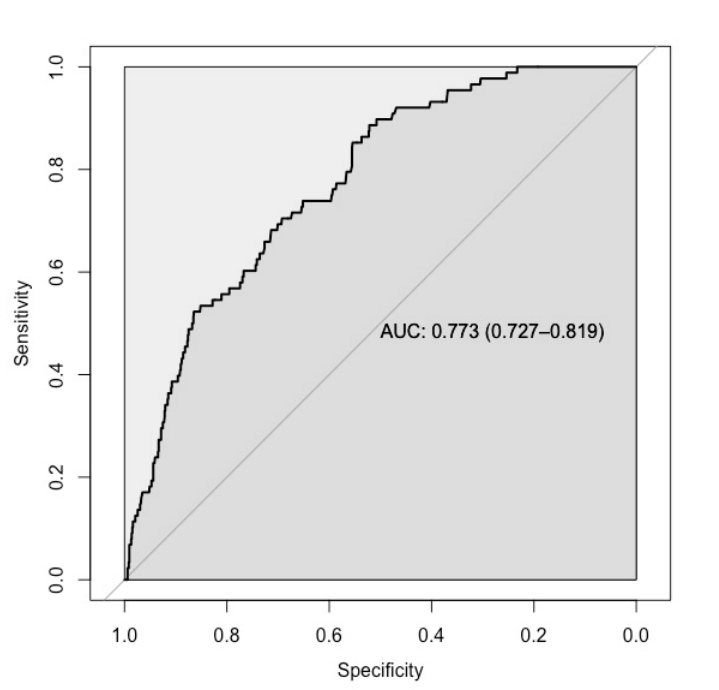
Figure S1 Receiver operator characteristics curve displaying the area under the curve (AUC) and the 95% confidence interval for the logistic regression model predicting in-hospital mortality in patients with